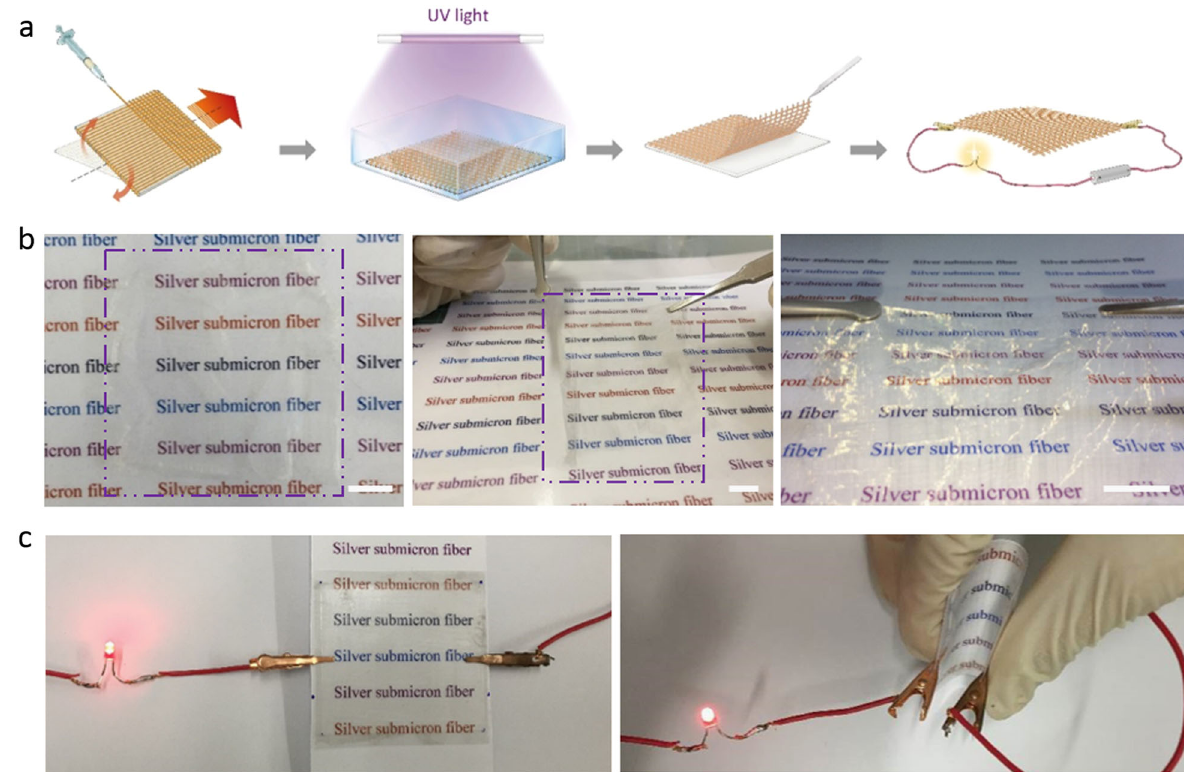
Fig. 1 Preparation process of silver submicron fi ber. a Schematic diagram for preparing the silver submicron fi ber at room temperature. b Digital photograph of silver fi bers after UV radiation for 5 h (scale bar: 1 cm), which shows that the silver fi ber mesh has excellent transparency and fl exibility. c Silver fi ber mesh attached in the PET fi lm that lightened on the LED lamp. (left: spread out; right: double